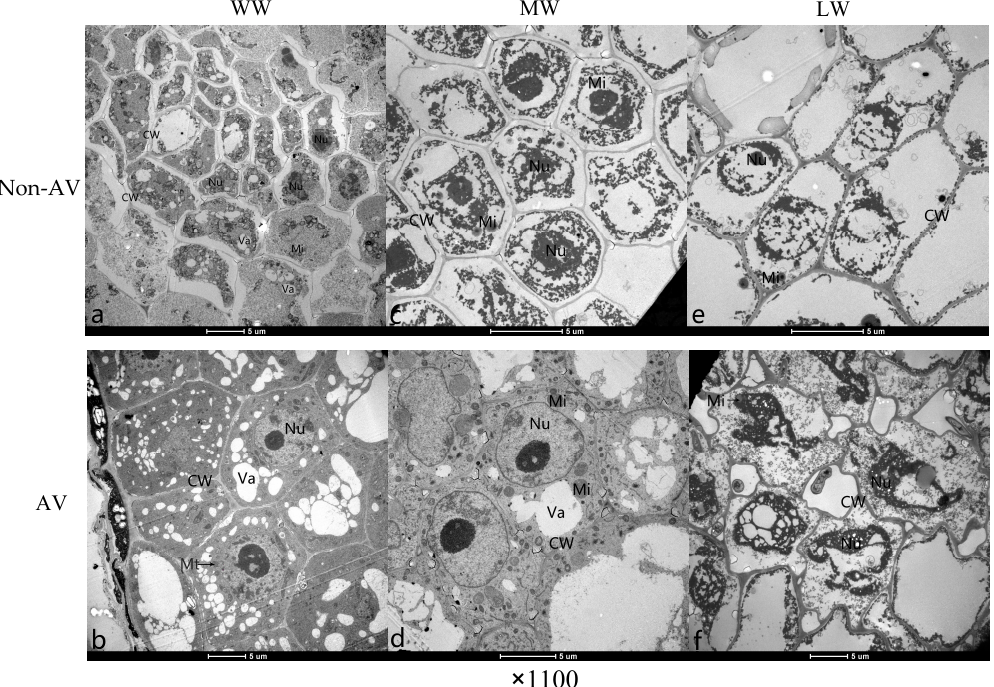
Figure 2. Transmission electron microscopy images of the ultrastructure of root cells of Ormosia hosiei seedlings inoculated with Acrocalymma vagum , a dark septate endophyte (DSE), and grown under drought stress conditions. Treatments: Non-AV, non- A. vagum ; AV, A. vagum ; WW, well watered; MW, moderate water; LW, low water; ( a ) root cell structure of Non-AV seedling under WW; ( b ) root cell structure of AV seedling under WW; ( c ) root cell structure of Non-AV seedling under MW; ( d ) root cell structure of AV seedling under MW; ( e ) root cell structure of Non-AV seedling under LW; ( f ) root cell structure of AV seedling under LW. Abbreviations: Ch, chloroplast; CW, cell wall; MI, mitochondria; Va, vacuole; Nu, cell nucleus.